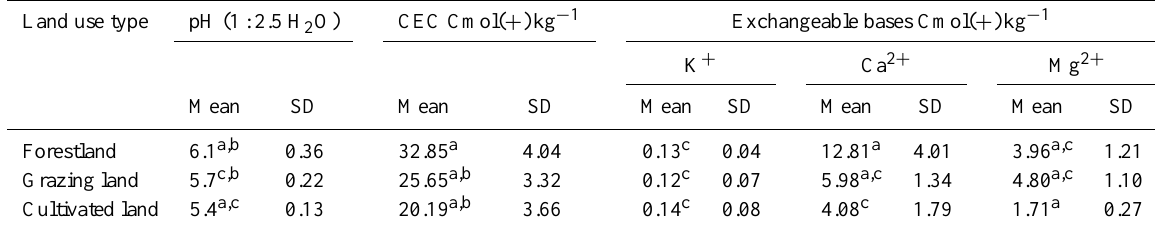
Table 3. Mean variation and standard deviation (SD) of soil acidity (pH), cation exchange capacity (CEC), and exchangeable bases (K + , Ca 2 + , and Mg 2 + ) at 0–15cm depth in different land use types in northeastern Wellega, Ethiopia. Land use